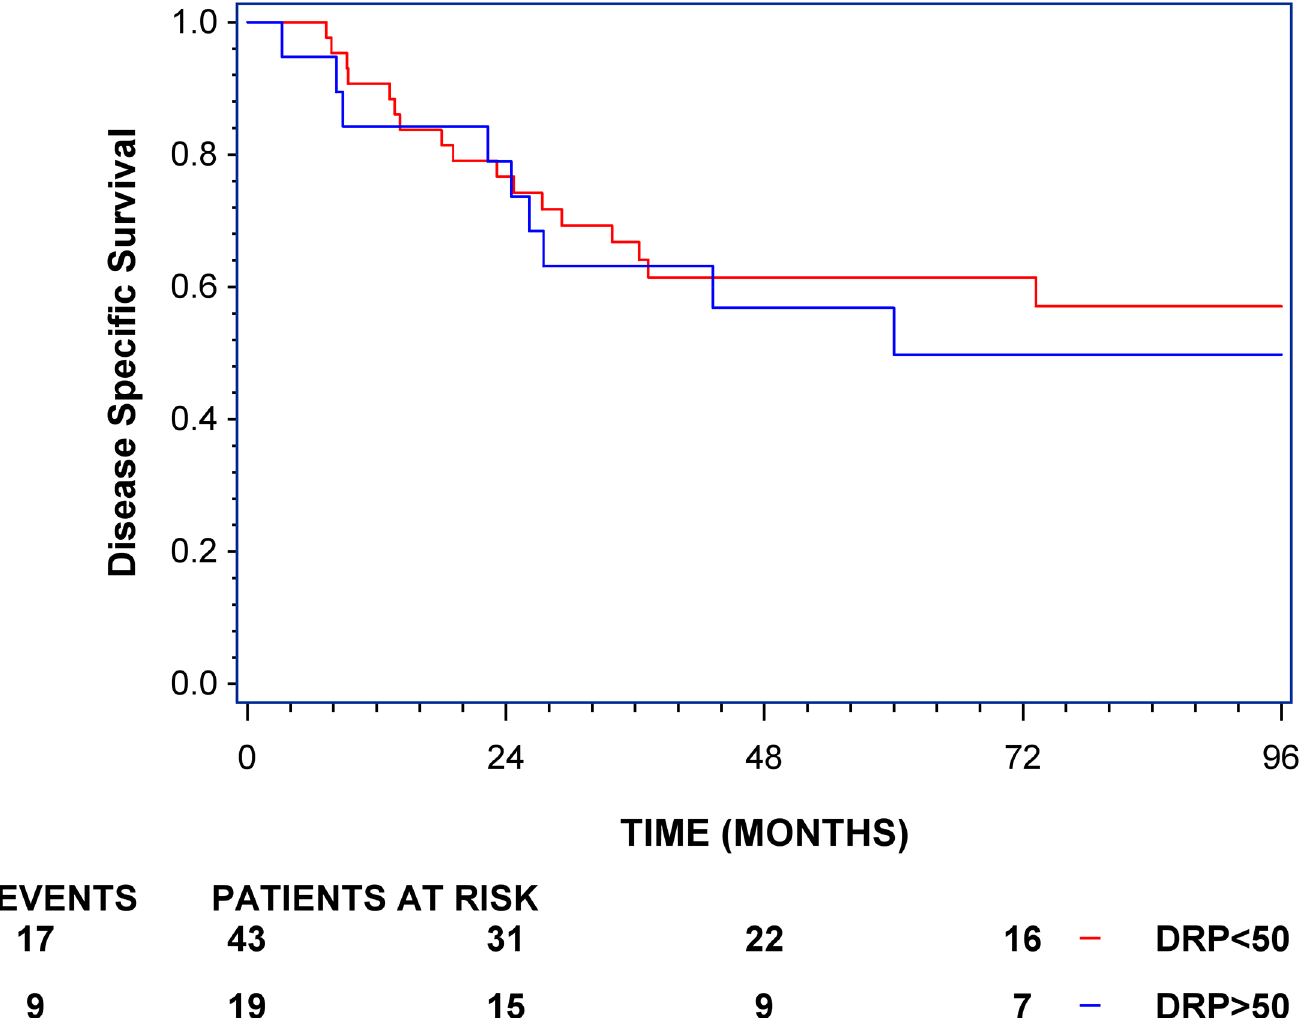
Fig 2. Kaplan-Meier curve of observational cohort (OBS) JBR.10, disease-specific survival. The curves show the observational cohort from JBR.10 divided by a score of 50. Underneath the curve is a description of events and patients at risk at different time points. Black: Combined cisplatin and vinorelbine score > 50, predicted high-likelihood responders to ACV; red: Combined cisplatin and vinorelbine score (cid:20) 50, predicted low-likelihood responders to ACV.